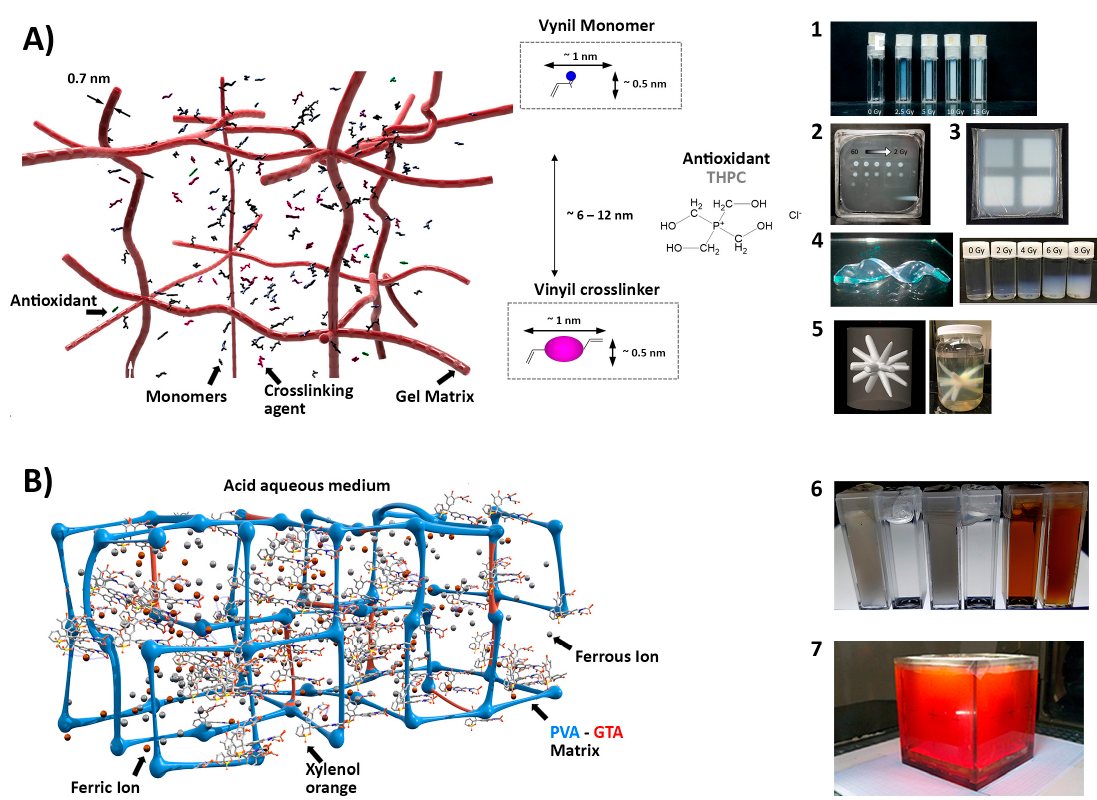
Figure 5. Schematic representation of gel dosimetry based on a gel matrix. ( A ) Polymer gel dosimetry scheme along with the typical dimensions for vinyl monomers. ( 1 ) PAGAT in a gelatin matrix, prepared in spectrophotometric cuvettes irradiated at different doses up to 15 Gy; ( 2 ) PAGAT in a gelatin matrix prepared in a layer-type container irradiated with circular collimation and different doses up to 60 Gy; ( 3 ) MAGT-A in a gelatin and agar matrix prepared in flexible film containers irradiated with squared collimation with doses up to 8 Gy (Reproduced with permission from refer- ence [122]); ( 4 ) Aquajoint TM matrix ( left ) and VIPET AQUA irradiated up to 8 Gy ( right ) (Reproduced with permission from reference [123]); ( 5 ) NIPAM in a gelatin matrix irradiated in an isocenter verifi- cation plan ( left ) and the TPS 3D rendering ( right ) (Reproduced with permission from reference [43]). ( B ) PVA-GTA Fricke gel dosimetry scheme. ( 6 ) Different PVA-GTA FGDs; from left to right: plain cryo-gel, plain PVA-GTA gel, Fricke cryo-gel, Fricke PVA-GTA gel, Fricke PVA-GTA gel with xylenol orange, and Fricke cryo-gel with xylenol orange (Reproduced with permission from reference [119]); ( 7 ) Fricke gel dosimetry in a gelatin matrix in a 1 L cubic